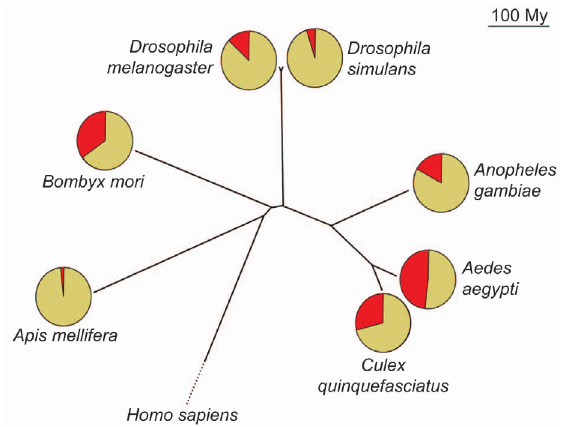
Figure 1 The frequencies of TEs in the genomes of a few well studied insect species are represented by the red sections. The relative abundances of TEs in these genomes are not correlated to the species